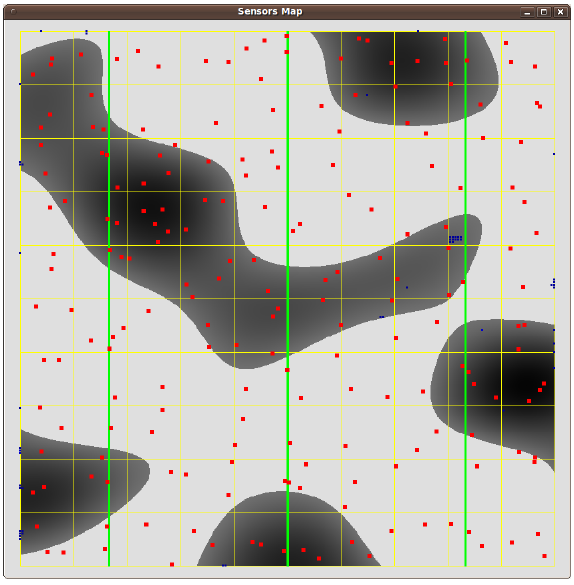
Figure 9. A sensor deployment for θ = 0 . 1 .